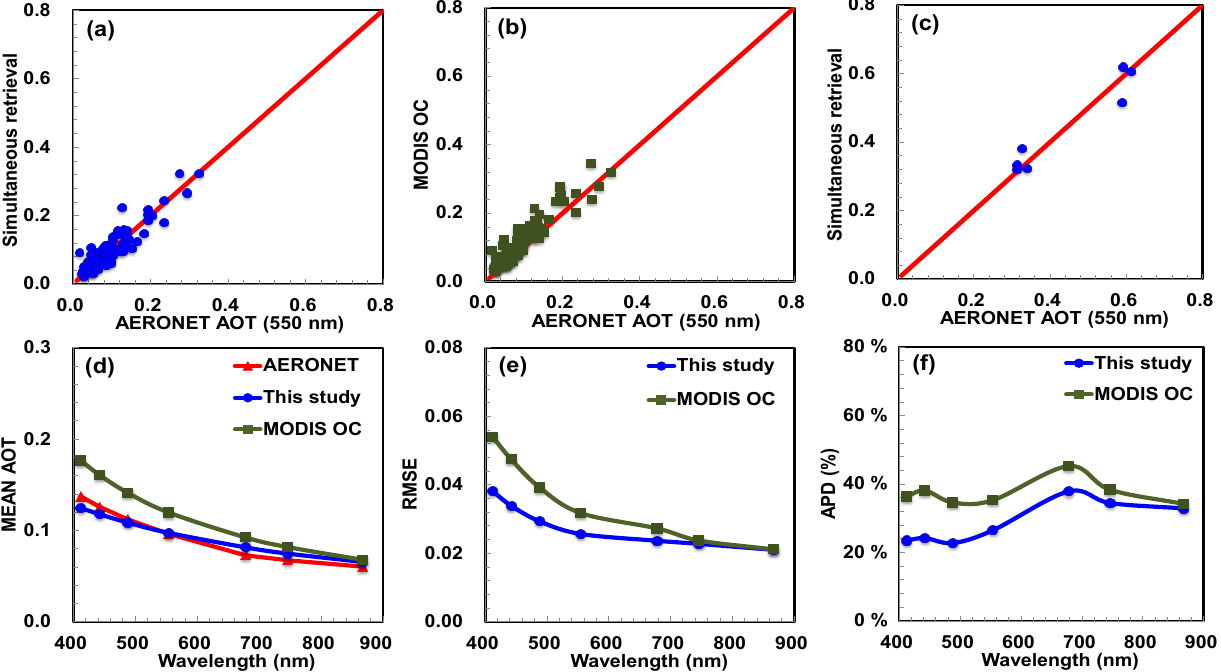
Figure 6. Comparison of jointly retrieved AOT at 550nm from the simultaneous retrieval algorithm (a) and MODIS OC products (b) using satellite measurements out of sunglint with AERONET-OC in situ products. Comparison of retrieved AOT at 550nm in high aerosol loading conditions from the current algorithm with AERONET-OC observation (c) . Statistical mean AOT values (d) , RMSE (e) and APD (f) results retrieved by these two approaches compared with AERONET-OC products at 412, 442, 488, 554, 670, 746 and